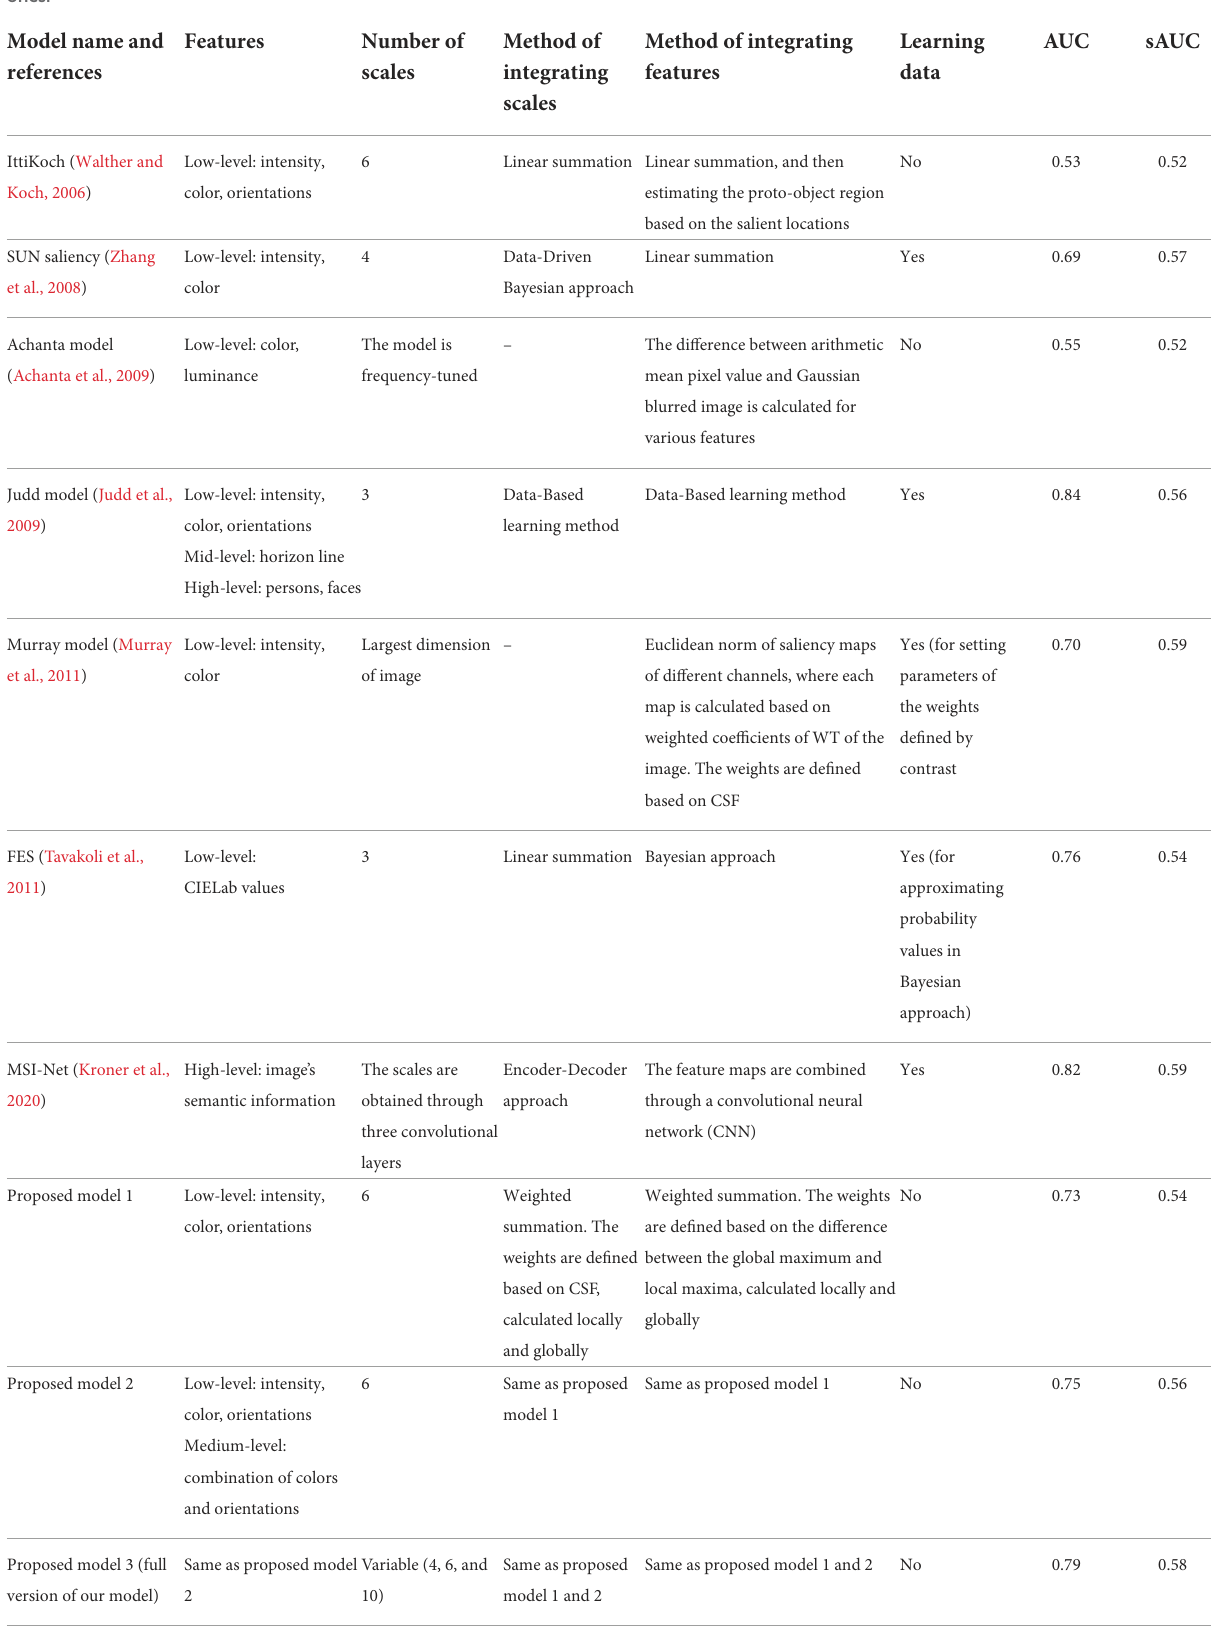
TABLE 2 Specifications of the models that were compared to our model in Figure 4, including the non-learning-based models and learning-based